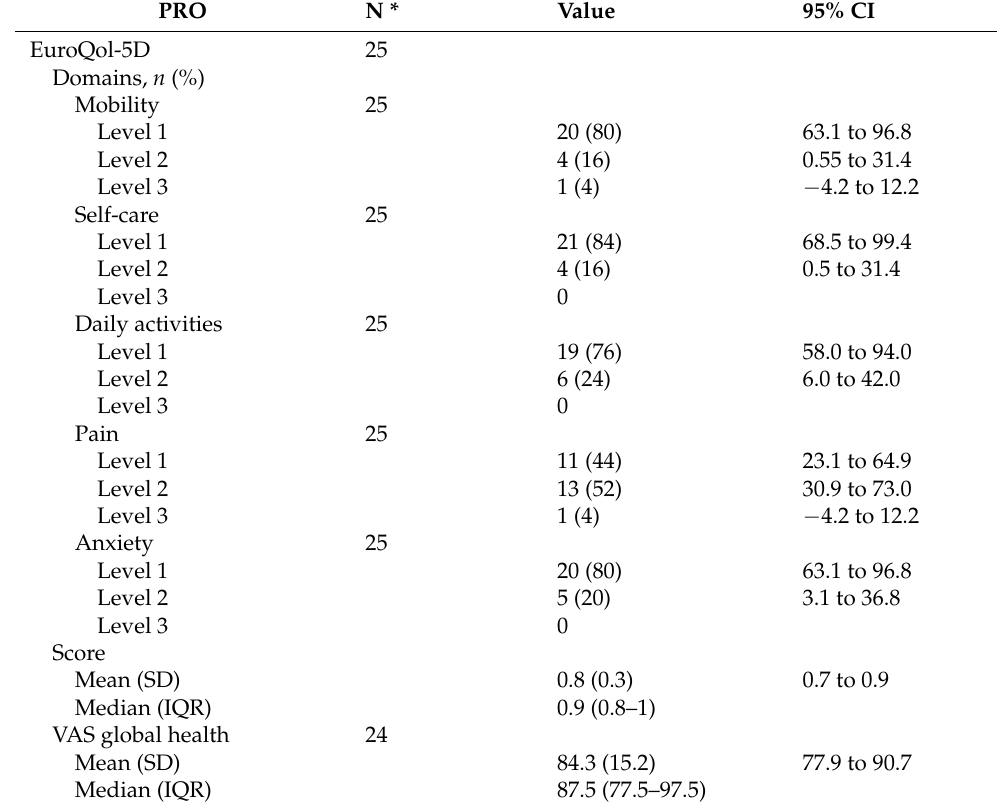
Quality of life and functional indices estimates in children and adolescents with Stickler